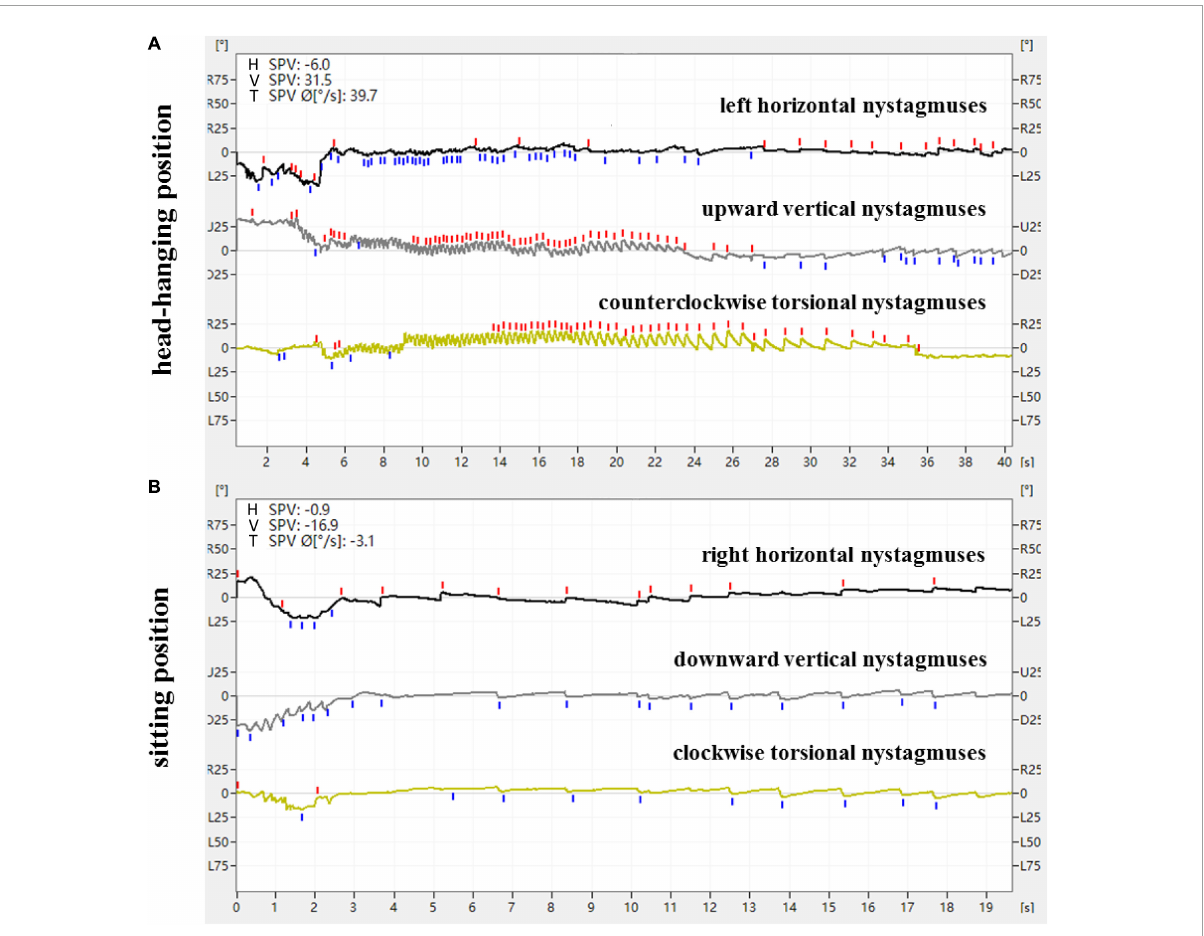
FIGURE2 Expression of nystagmus on the 3D-VNG by Dix-Hallpike test of a patient with R-PSC-can. (A) At the head-hanging position, the left horizontal nystagmuses were recorded as downward fast-phase nystagmus curves, the upward vertical nystagmuses were recorded as upward fast-phase nystagmus curves, and the counterclockwise torsional nystagmuses were recorded as upward fast-phase nystagmus curves. (B) The direction of nystagmus was reversed when the head was recovered from the head-hanging position to the sitting position.